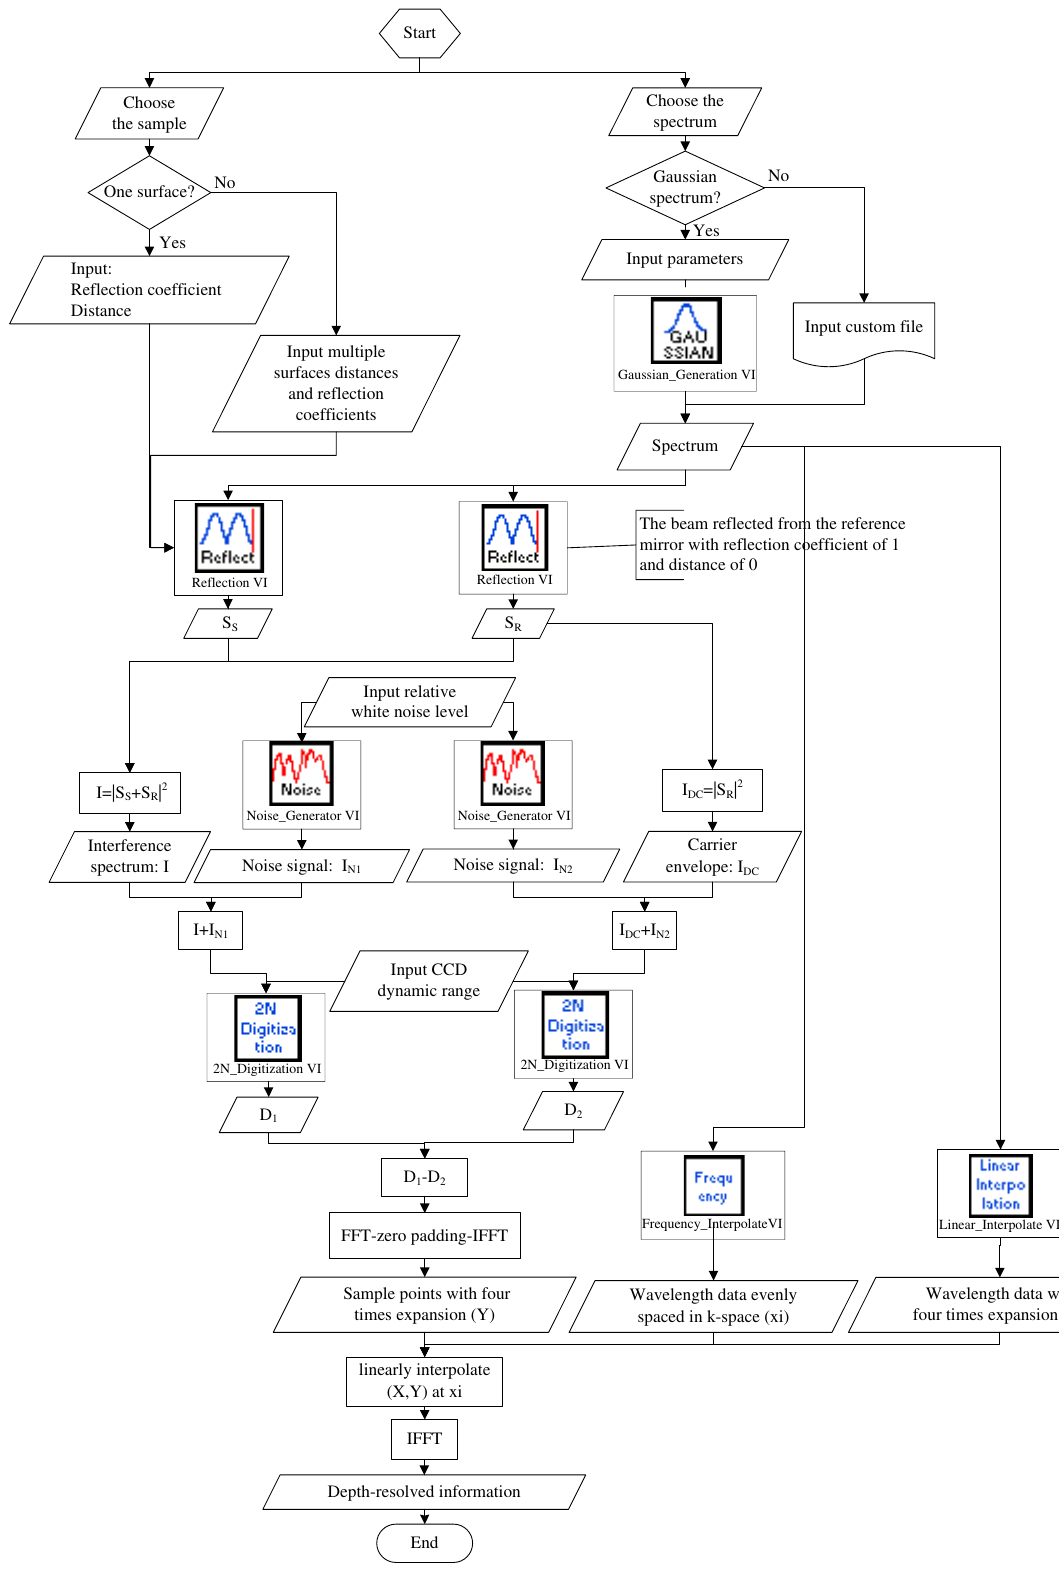
Fig. 5. The °owchart of the SD-OCT A-scan